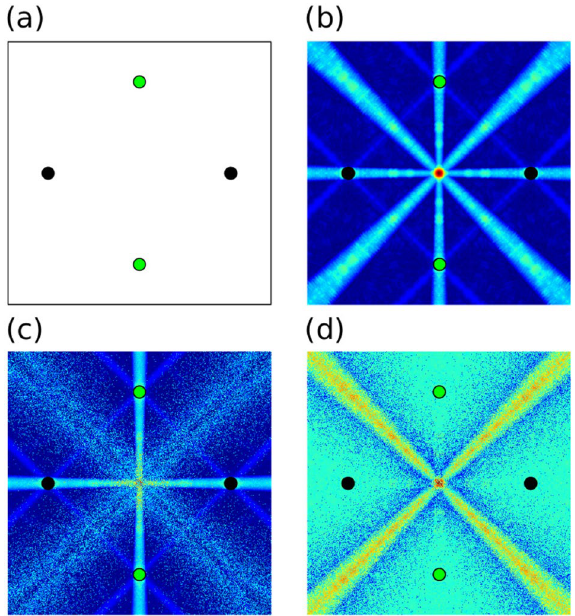
Figure 4. Two sets of data, green and black, ( a ) are processed by combining the inputs ( b ), resulting in both inter-set and intra-set symmetry at the output. To obtain a result with only inter-set symmetry, two distinct pseudorandom codes are applied to the two data sets, dispersing inter-set results ( c ). To obtain a result with only intra-set symmetry, the inter-set output ( c ) is subtracted from the original, or generated with inhibitory spiking in a spiking neural network, ( b ) to obtain the intra-set only result ( d